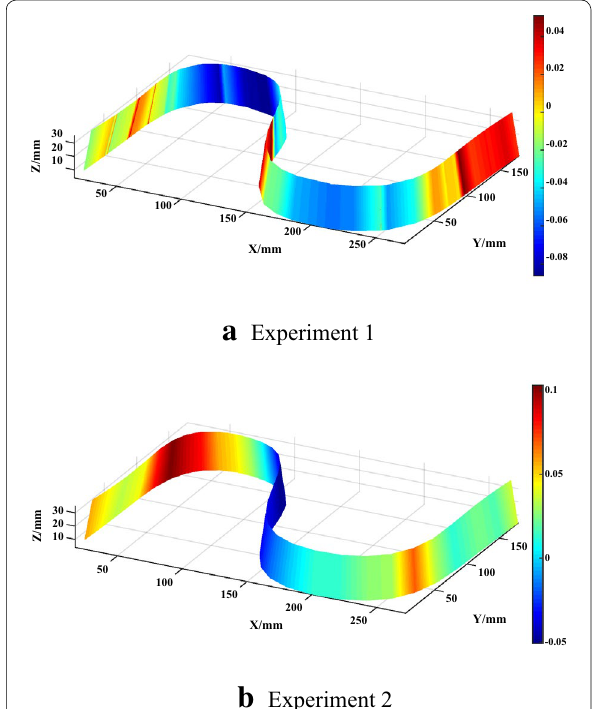
Figure 3 Distributions of deviations on two S-shaped test specimens